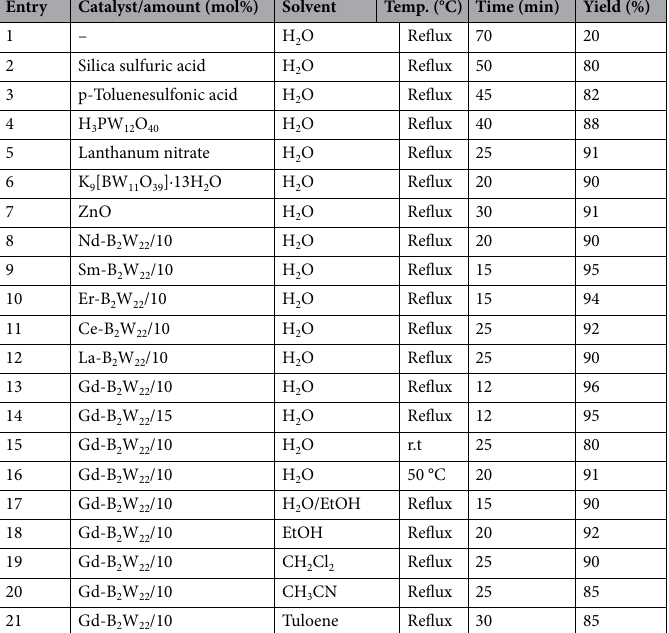
Table 2. Optimization of the reaction